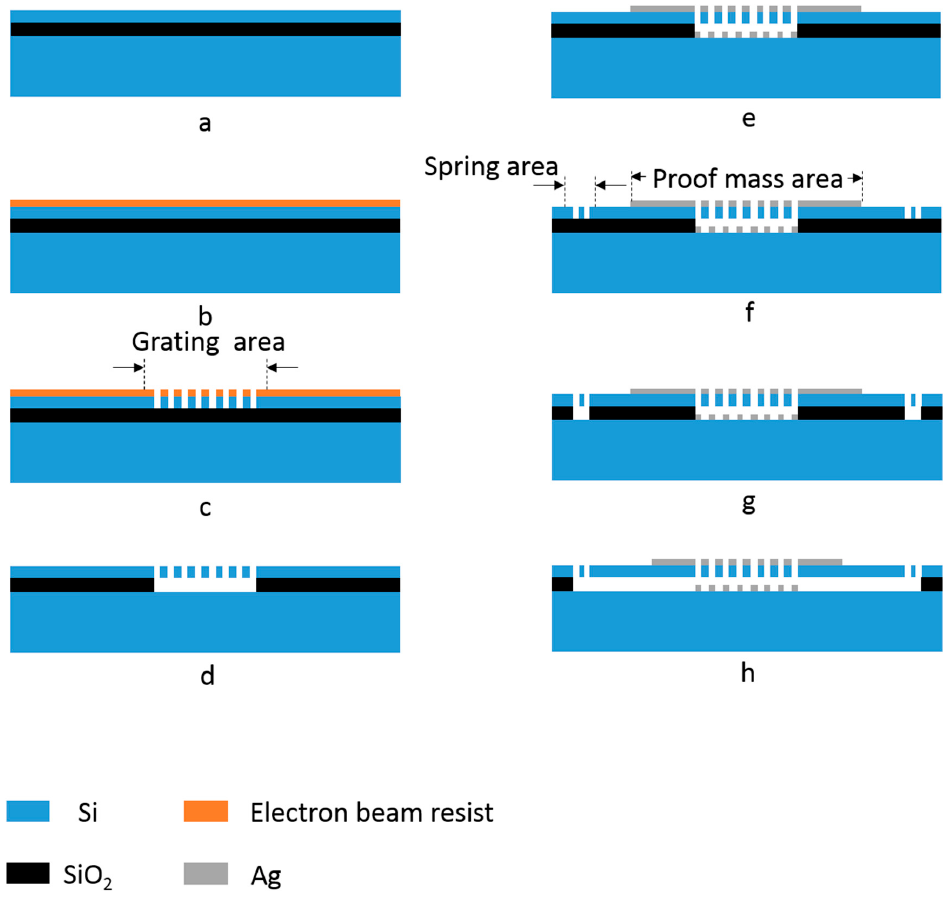
Figure 14. Process flow for fabrication of the micromachined structure. ( a ) Starting mirror polished SOI wafer; ( b ) spin coat the electron beam resist; ( c ) make the pattern of grating lines by electron beam lithography (EBL) and etch the device layer to the buried oxide layer by inductively coupled plasma (ICP) etching; ( d ) release the grating area by buffered oxide etch (BOE); ( e ) deposit Ag and then use lift-off to pattern the upper metal film; ( f ) also use EBL and ICP to pattern and etch the springs; ( g ) release the suspended springs by BOE; ( h ) release the proof mass to make the whole device